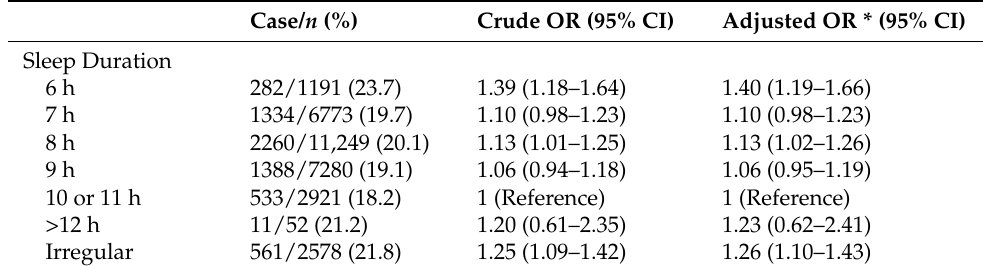
Table 3. Logistic regression analysis to investigate the relationship between sleep duration and injuries at 5.5–9 years